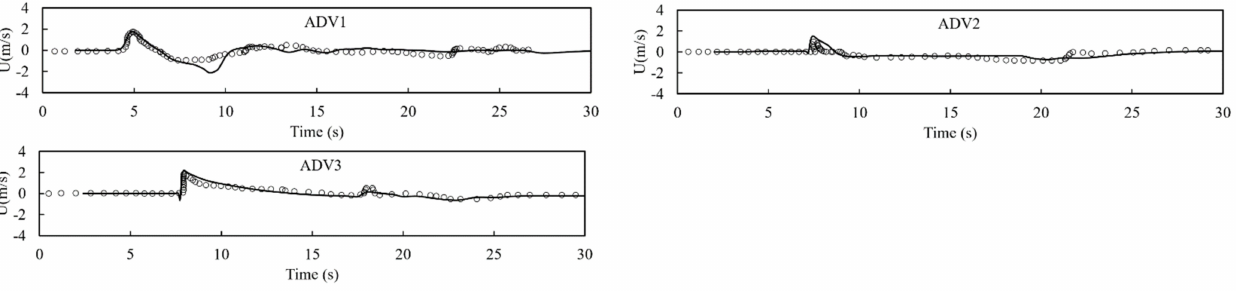
Figure 17. Comparison of simulated and measured velocities in the x direction at the acoustic Doppler velocimeters locations. Experimental data (circles), numerical results (solid